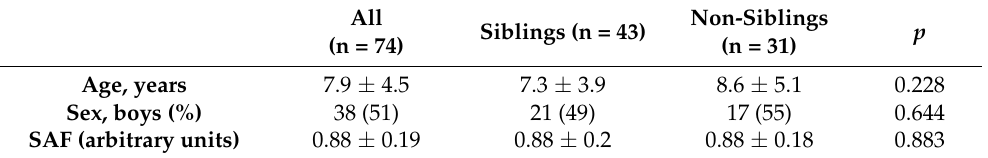
Table 2. Baseline characterization of controls.